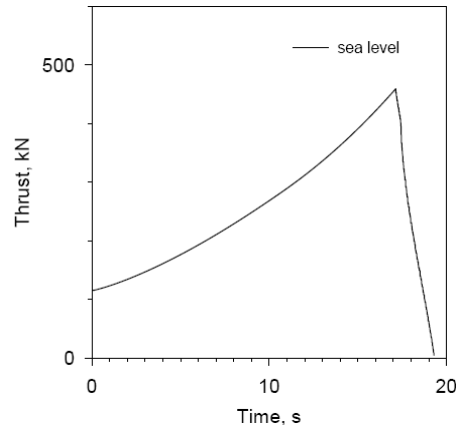
Figure 8. Predicted thrust profile for scaled-up cylindrical-grain